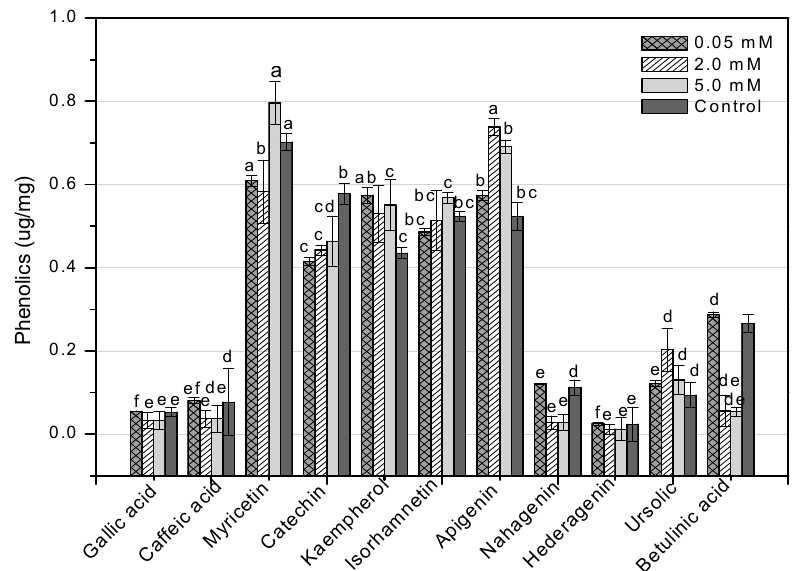
Figure 14. HPLC-based quantification of phenolic compounds in F. indica calli elicited with seven different concentrations of cadmium chloride along with control. Mean values with standard errors (± SE) and bars labeled with different letters (LSD values) exhibit significant variation ( α < 0.05).